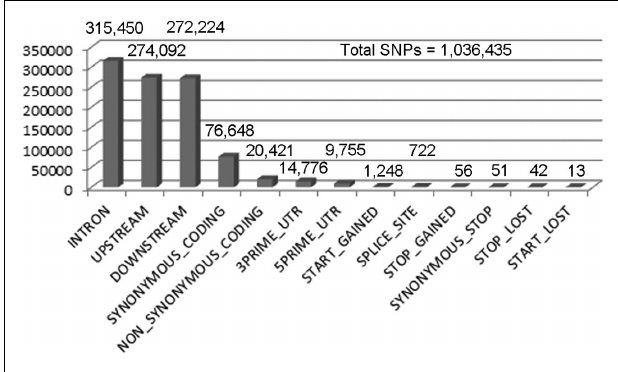
FIGURE 2 | Single nucleotide polymorphism calling for X1 SNPs with a quality score greater than or equal to 70. We performed SNP calling using Samtools, which produced 1,943,047 SNPs with a quality score > 1. Out of these, 1,036,435 are homozygous SNPs.The low quality SNPs were filtered out using an arbitrary threshold of 70 (the peak of the distribution) leaving 204,205 homozygous SNPs. A summary of the remaining homozygous SNPs found in each category is shown in the numbers above the bars.